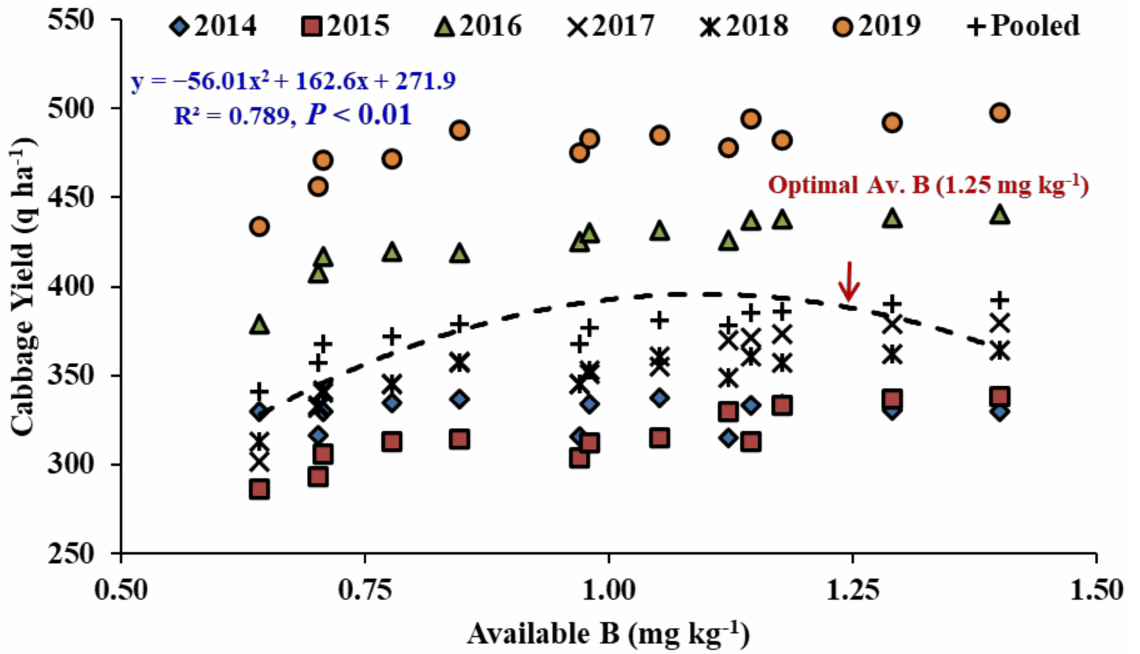
Figure 4. Response function and physical optimal available B for the highest cabbage-head yield in relation to B fertilization to groundnut crop in groundnut-cabbage cropping